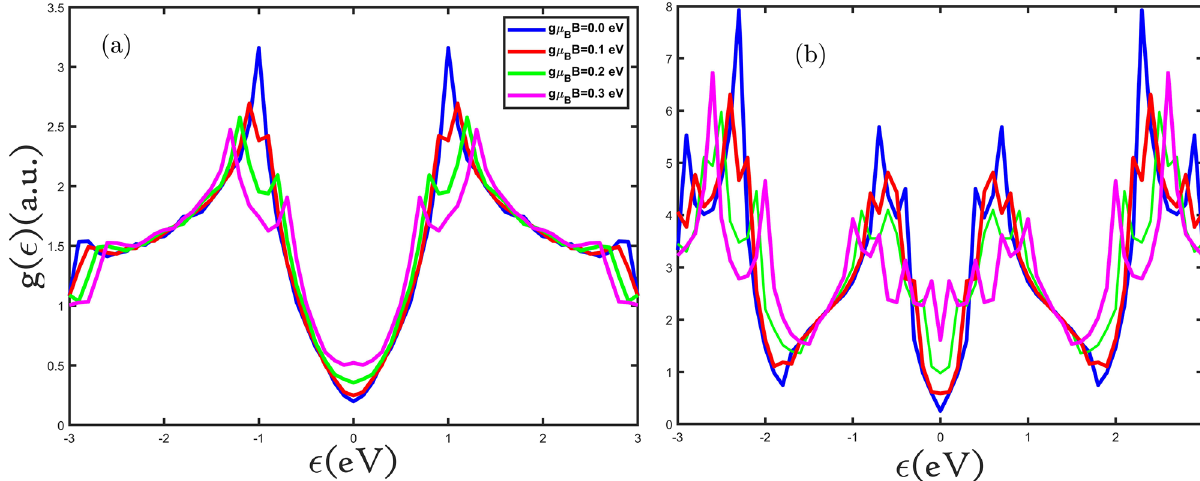
Figure 2. ( a , b ) The electronic density of states of the planar and buckled silicene monolayer in the presence of the external magnetic field.